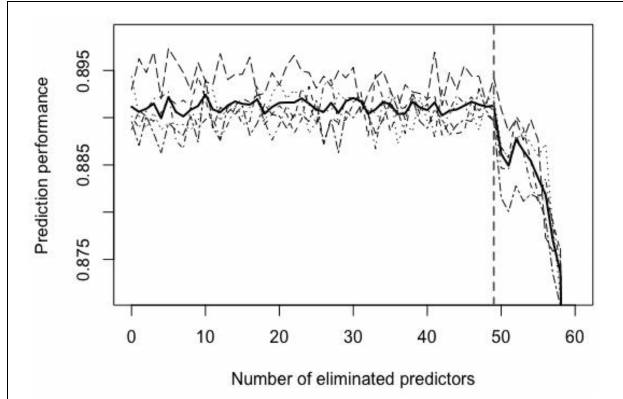
FIGURE 3 | Prediction performance versus number of eliminated predictors for a backward elimination. Dashed lines record the change of validation performance (classification accuracy) for each training set as the number of eliminated feature increases; the bold solid line represents the average performance for five-fold; the vertical dashed line (the number of excluded features=49) indicates where a large reduction of prediction performance begins.